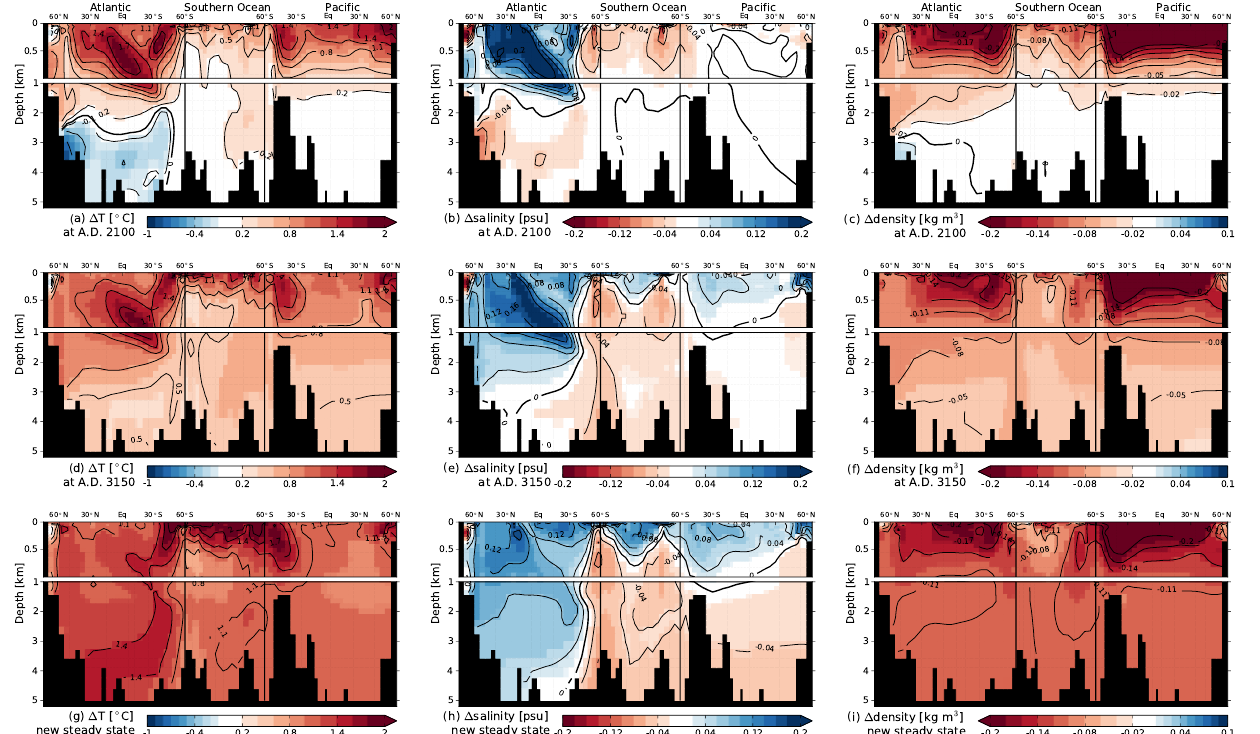
Figure A2. Changes in temperature, salinity and density at AD2100 (a–c) , at AD3150 (d–f) and for new steady-state conditions (g–i) compared to pre-industrial